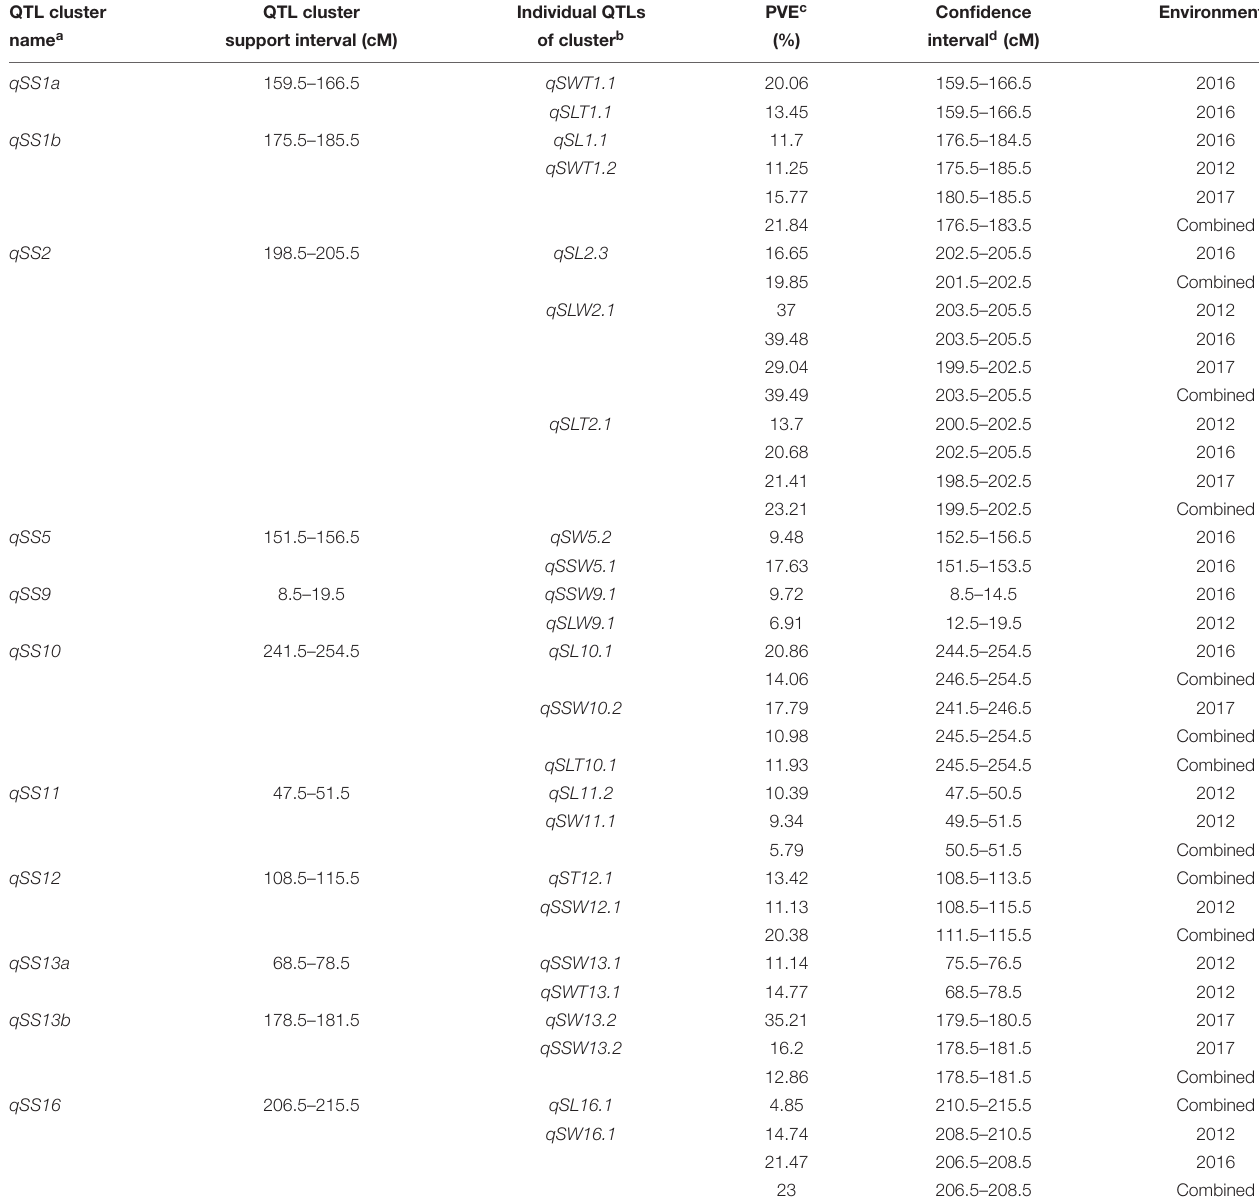
TABLE 3 | QTL clusters for seed size and shape traits in K099 × Fendou 16 RIL population. QTL cluster QTL cluster Individual QTLs PVE